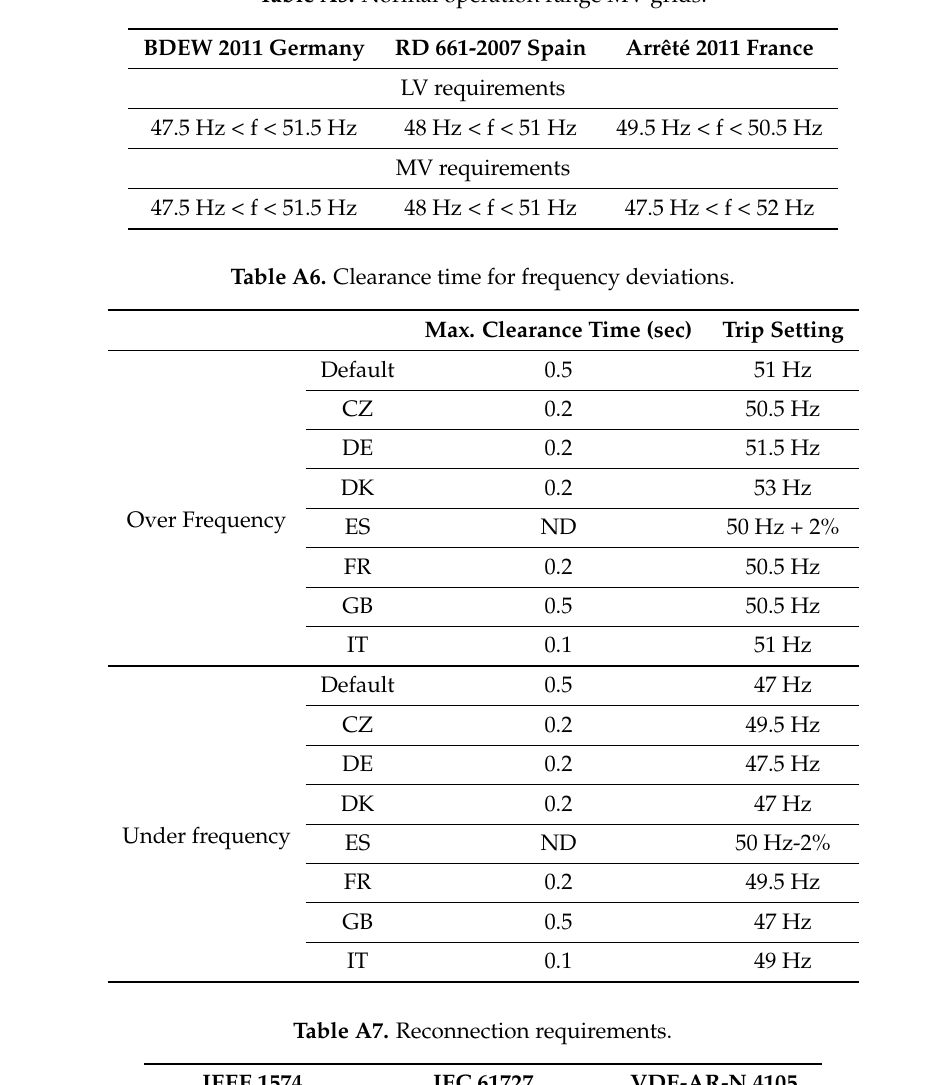
Table A5. Normal operation range MV grids.